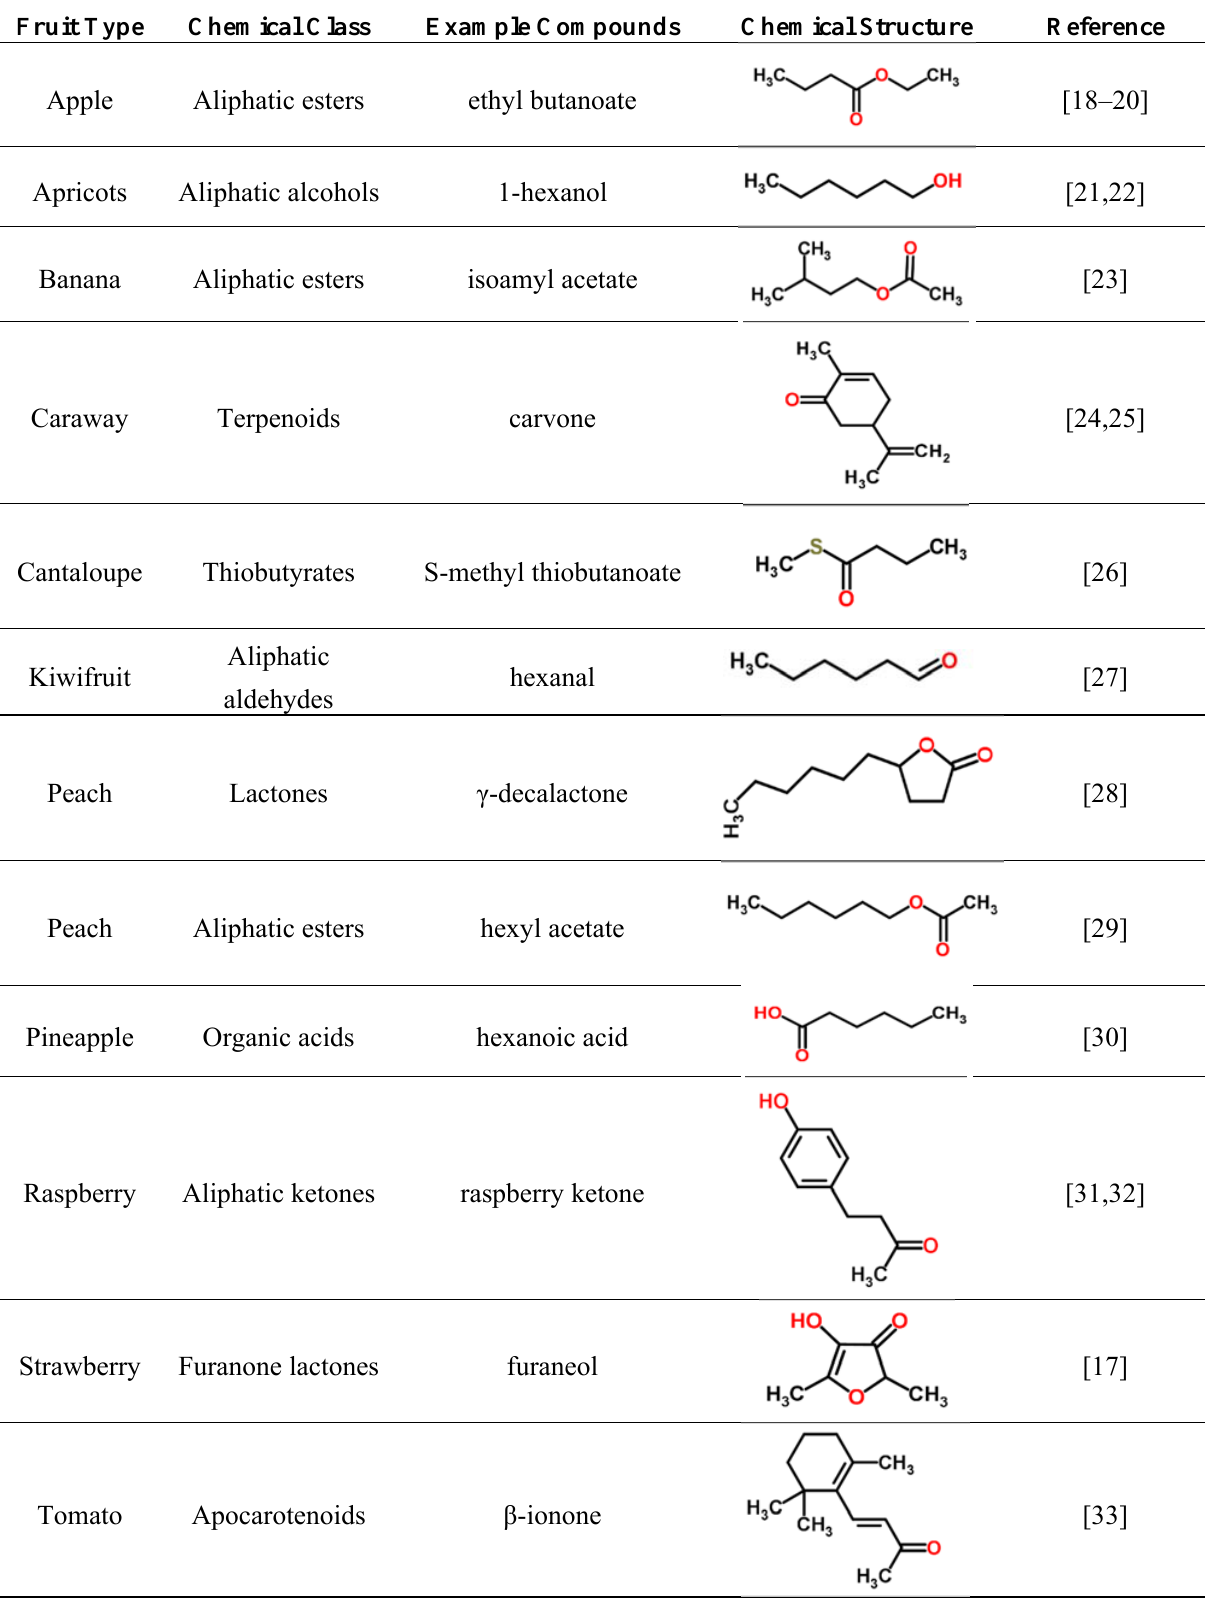
Table 1. Chemical classes of VOCs that are principal components of distinctive fruit aromas. Fruit